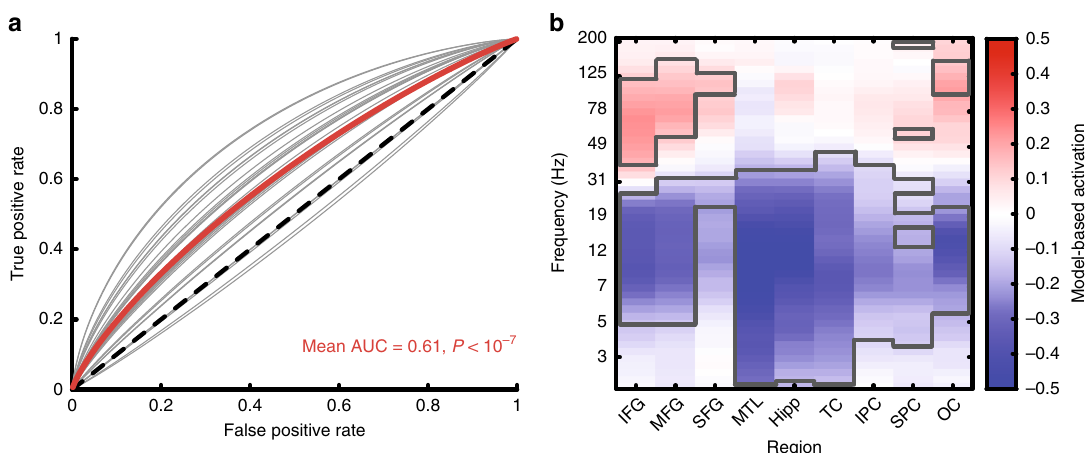
Fig. 2 Classi fi er performance and features. a Receiver operating characteristic (ROC) curves showing performance of a record-only classi fi er tested on NoStim lists during the closed-loop sessions (gray lines). Each curve displays the ROC for a unique subject – stimulation site. The group average is shown in red (mean AUC = 0.61, P < 10 − 7 by a one-sample t -test, N = 29 unique stimulation targets). b Forward model-based estimates of feature importance. For each electrode region by frequency feature, we computed a forward model-based estimate of the feature ’ s contribution to the classi fi cation decision 34 . This analysis shows that the classi fi er used increased high-frequency power combined with decreased low-frequency power to predict successfully recalled words (clusters signi fi cant at the P < 0.05 level by a one-sample t -test are outlined in gray, N = 25 record-only classi fi ers)